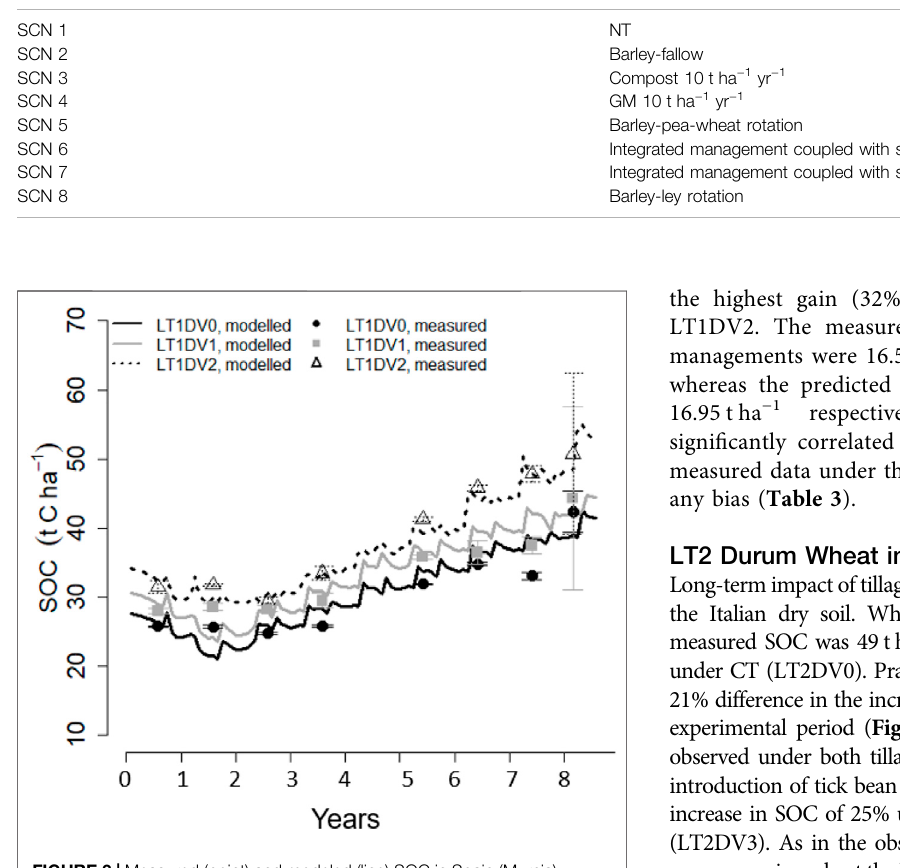
Frontiers in Environmental Science |